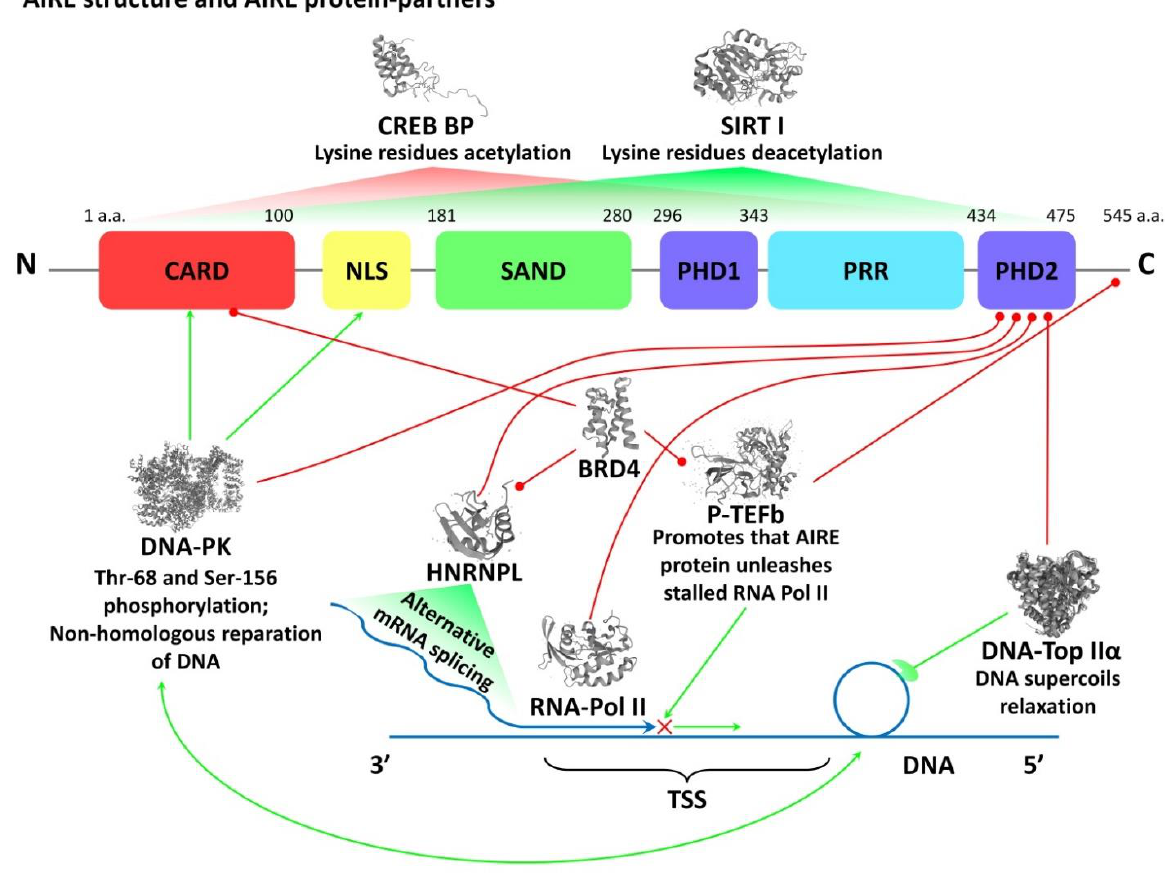
Figure 3. Molecular structure and functions of AIRE transcription regulator. Explanations are in the text. Red lines show spatial contacts in the AIRE multimolecular complex. Green arrows show functional interconnections in the AIRE multimolecular complex. AIRE, autoimmune regulator; CARD, caspase activation and recruitment domain; NLS, nuclear localization signal; SAND domain is named after a range of proteins: Sp100, AIRE-1, NucP41/75, DEAF-1; PHD, plant homeodomain; PRR, Proline-rich region; CREB BP, CREB binding protein; CREB, cAMP response element-binding protein; SIRT, Sirtuin; DNA-PK, DNA-dependent protein kinase; HNRNPL, heterogeneous nuclear ribonucleoprotein L; RNA-Pol II, RNA polymerase II; BRD4, Bromodomain-containing protein 4; P- TEFb, positive transcription elongation factor b; DNA-TOP IIα, Type II DNA topoisomerase; TSS, transcription start site. Three-dimensional structures of proteins were obtained from https://www.uniprot.org/ (accessed on 15 October 2021).